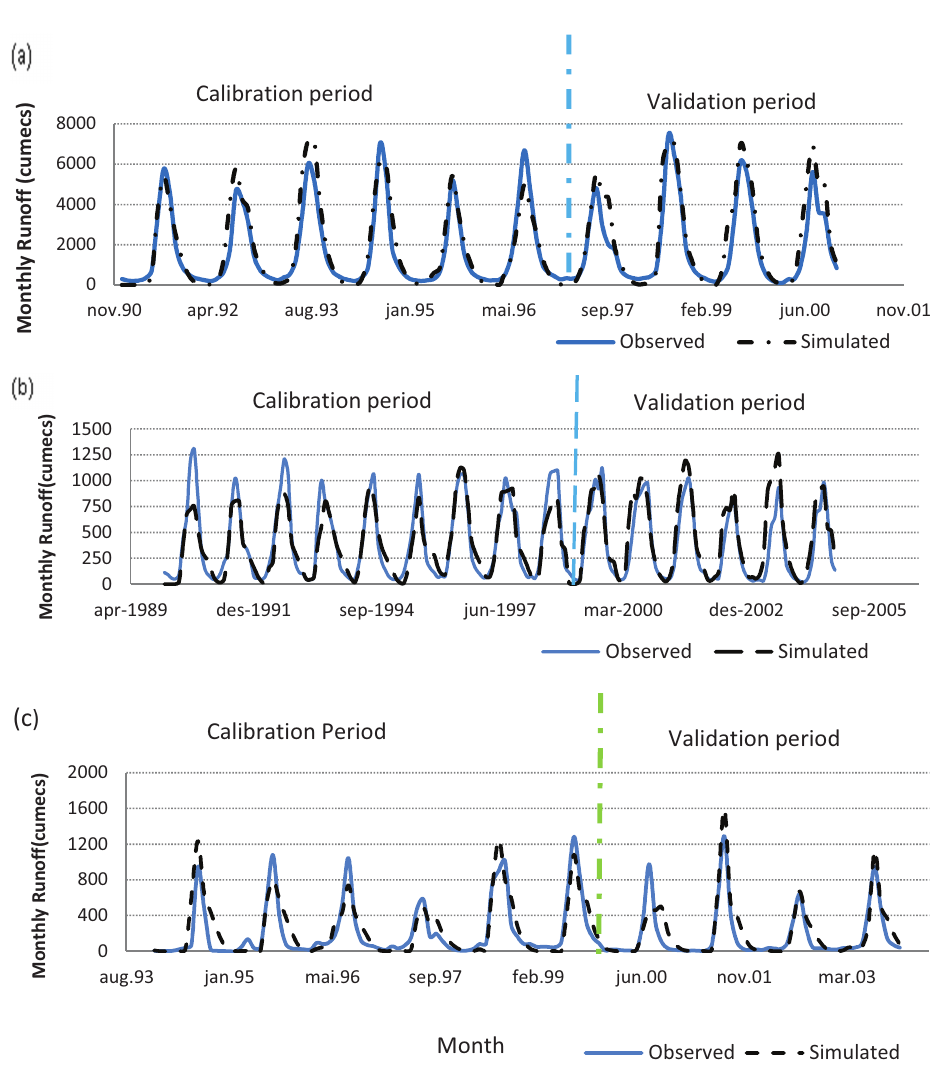
Figure 6: Daily observed (blue) and simulated (red) streamflow during the calibration and validation periods for the (a) Baro Akobo at Gambella and (b) Tekeze at Embamadre.